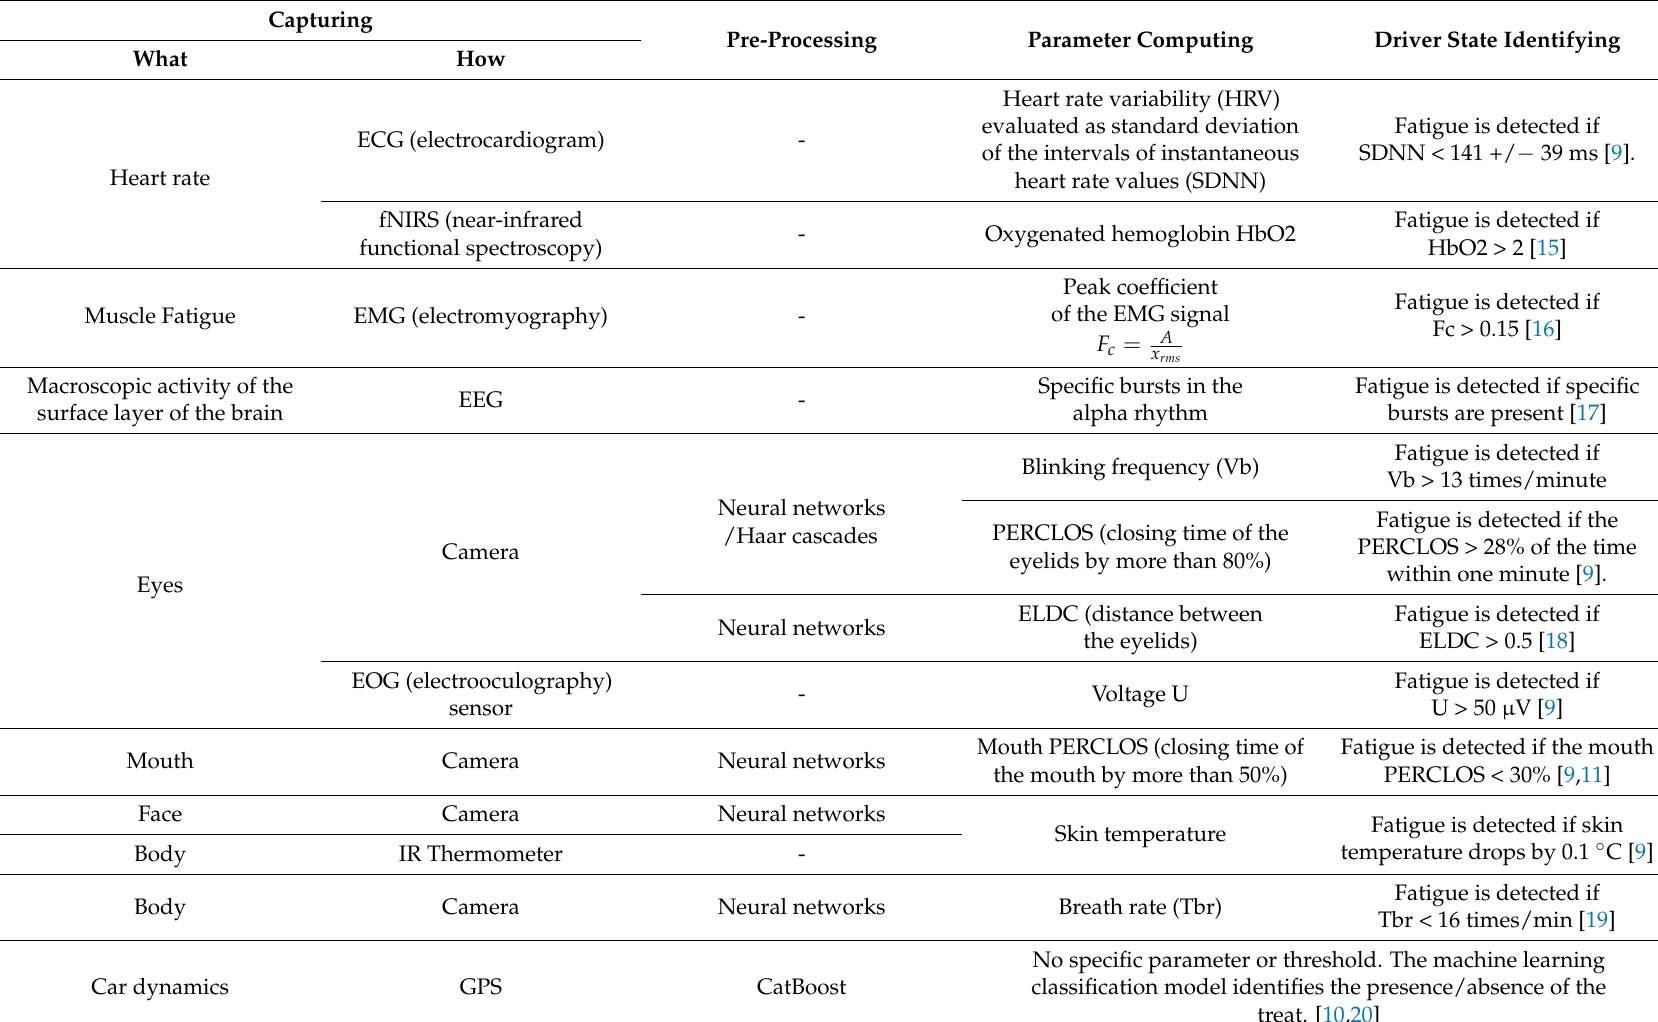
Table 1. Technologies for stages of the threat detection